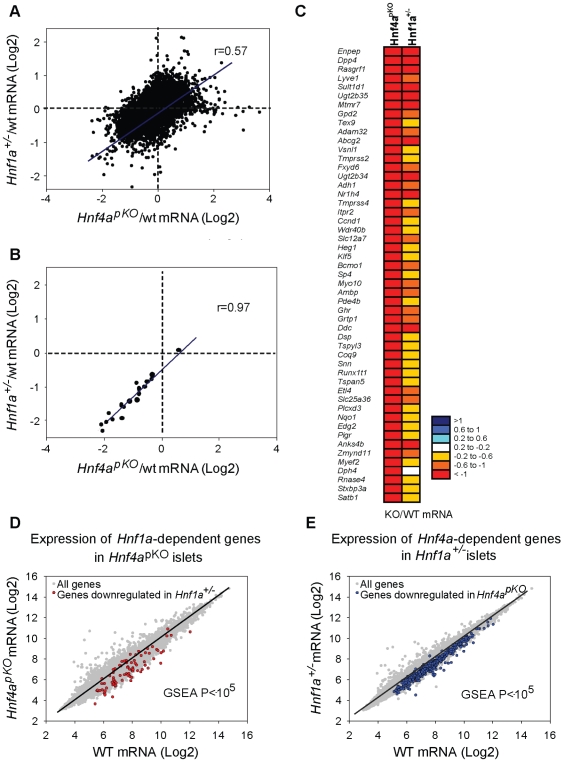
Hnf1α and Hnf4α regulate a common set of genes.(A) Correlation of mutant/wild-type Log2 gene expression ratios in Hnf4apKO versus Hnf1a+/− islets. (B) Validation of 22 genes using gene-specific qPCR. (C) Heatmap of expression ratios in Hnf4apKO and Hnf1a+/− islets for the 50 most downregulated genes in Hnf4apKO islets. (D) Expression of Hnf1a-dependent genes in Hnf4apKO islets. Grey dots represent average expression values of genes in Hnf4apKO versus control islets. We superimposed red dots to show the subset of genes downregulated in Hnf1a+/− islets. (E) Expression of Hnf4a-dependent genes in Hnf1a+/− islets. Grey dots are expression values of all genes, superimposed blue dots are the subset of genes downregulated in Hnf4a
pKO islets.